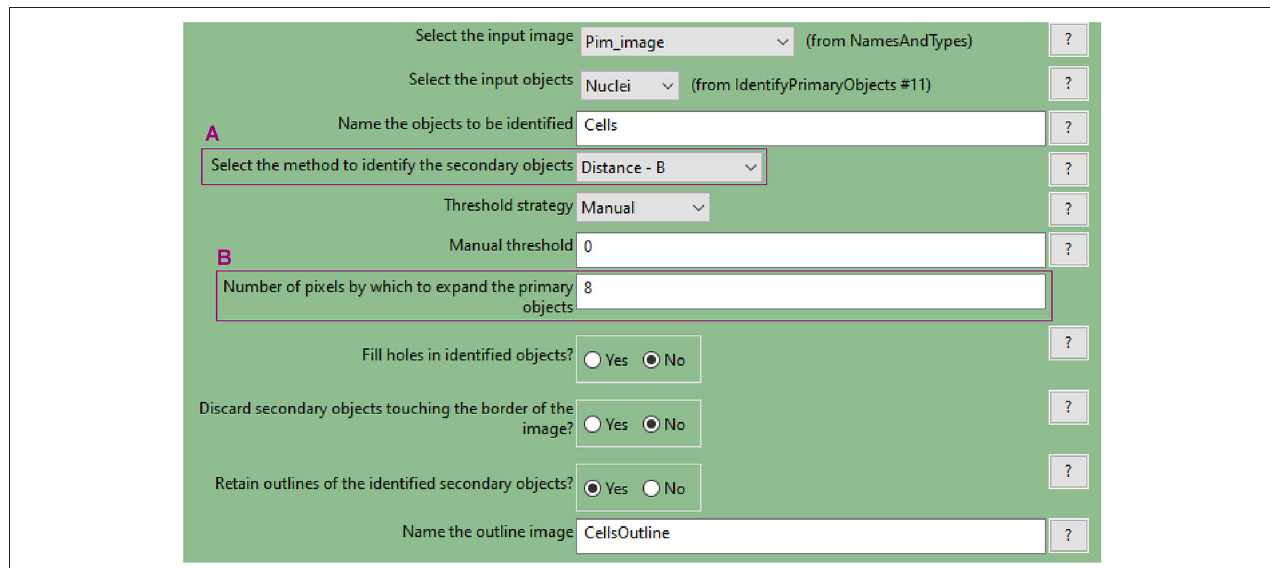
FIGURE 7 | CellProfiler “IdentifySecondaryObjects” module interface. Parameters used to identify spheroid cells (cytoplasm included) for analysis shown in Figure 3 .